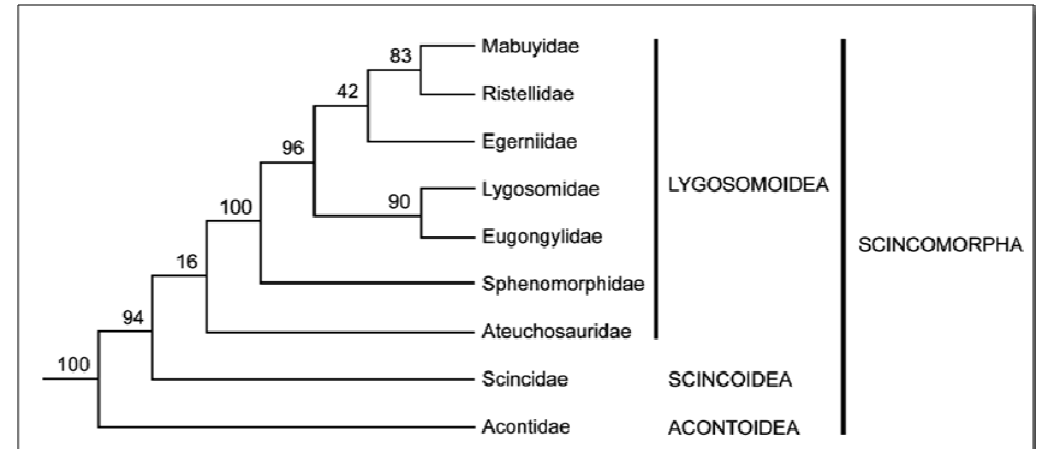
F IGURE 1. Phylogenetic tree of skink families and superfamilies that are well supported